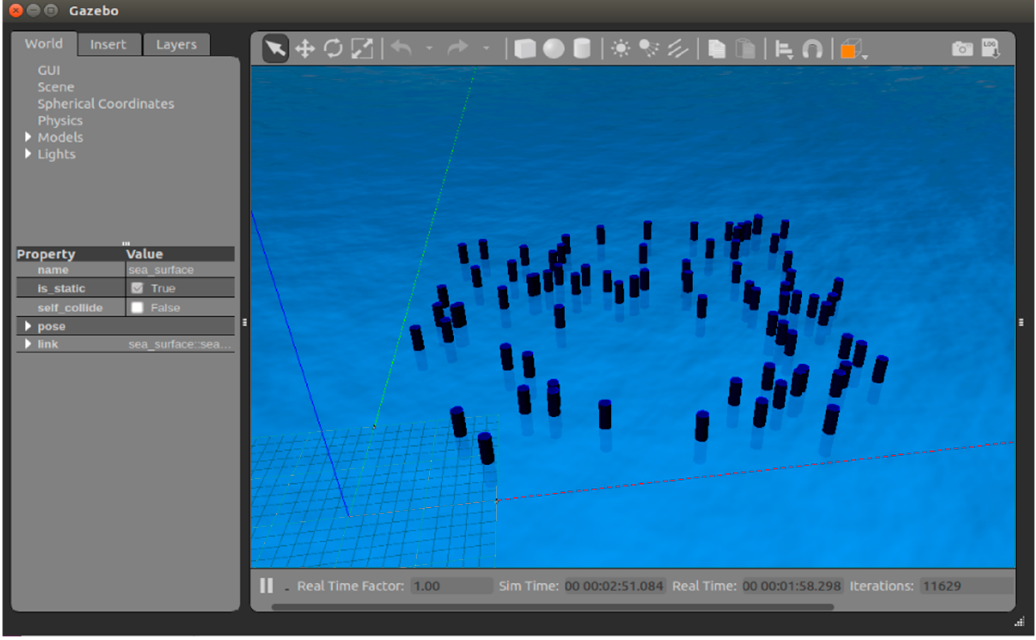
Figure 8. The simulation scenario in ROS/Gazebo.